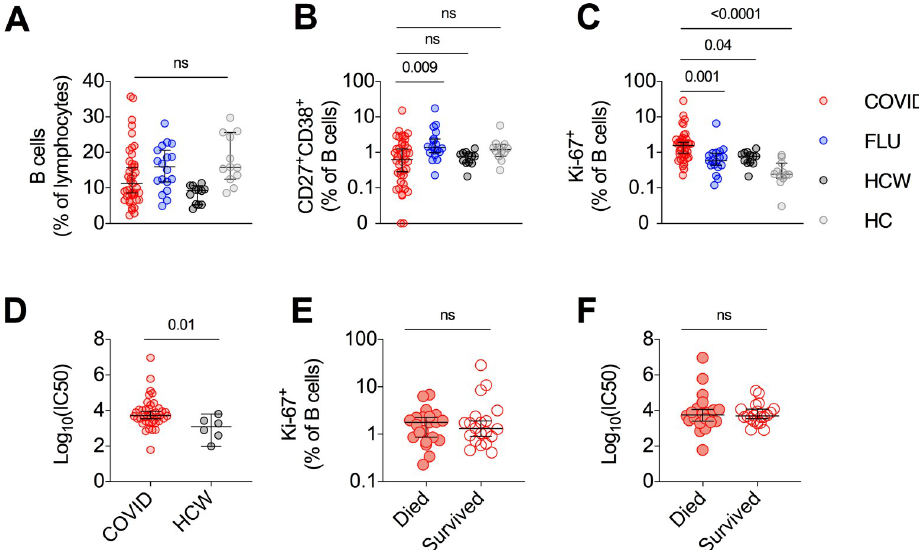
Fig 2. No association between SARS-CoV-2 neutralizing antibodies and fatal outcome in critically ill COVID-19 patients. (A - C) Frequency of B cells (A) CD27 + CD38 + plasmablasts (B) and Ki-67 + proliferating B cells (C). (D) Log 10 of the reciprocal plasma dilution that neutralized 50% of SARS-CoV-2 spike protein-expressing pseudovirus. 50% Inhibitory concentration (IC50). (E - F) Frequency of Ki-67 + B cells (E) and Log 10 of the reciprocal plasma dilution that neutralized 50% of SARS-CoV-2 spike protein-expressing pseudovirus (F) with critically ill COVID-19 patients stratified by survival. Median ± 95% CI are shown. (A to C) Kruskal-Wallis tests with Dunn’s multiple comparison test. (D to F) Mann-Whitney